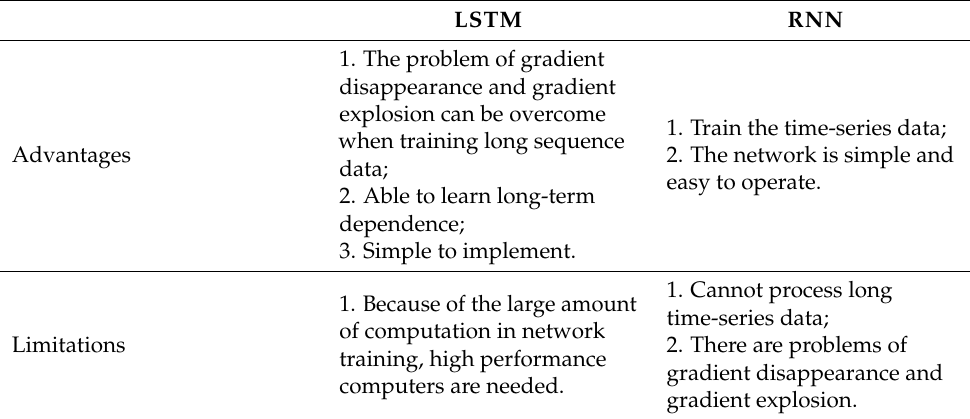
Table 1. Advantages and limitations of RNN and LSTM.